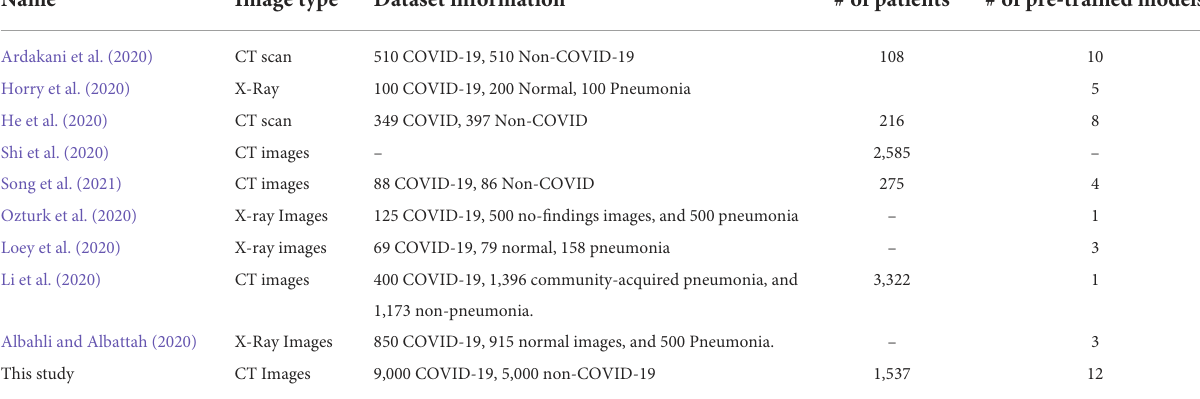
TABLE 1 Dataset information from previous